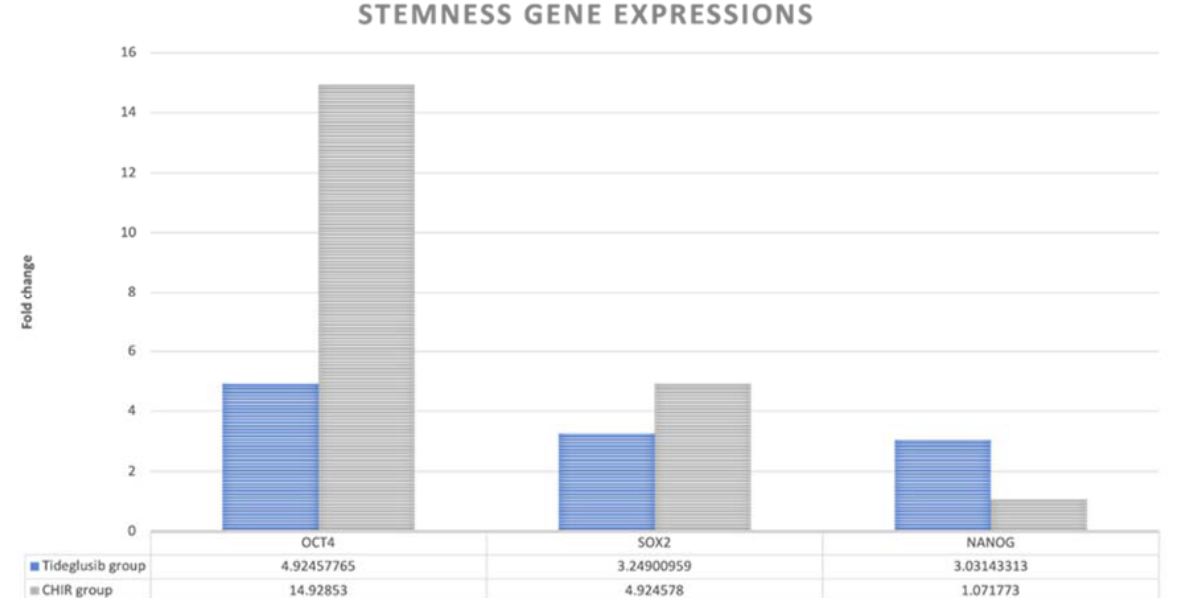
Figure 8. Chart presenting the different genes expression (OCT4, SOX2, and NANOG) within the study groups in relation to the control group (fold change).